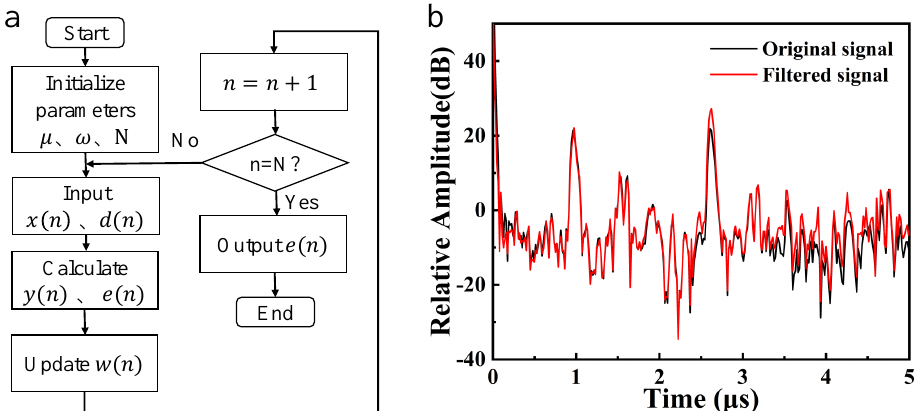
Figure 4. ( a ) Adaptive LMS algorithm flow; ( b ) original and denoised response in time domain of the SAW